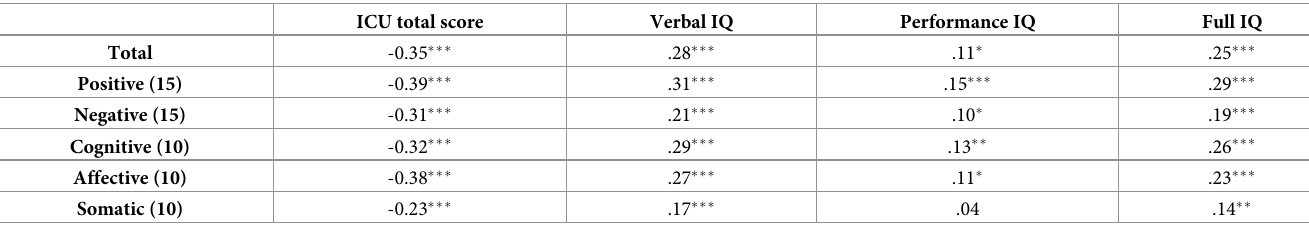
Table 5. Associations between CASES empathy scales, ICU and